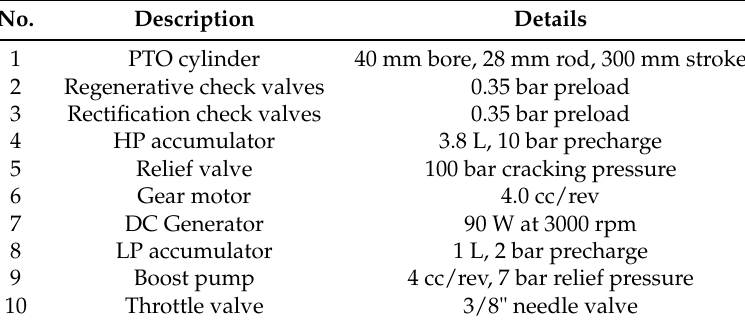
Table 1. Constant pressure test rig